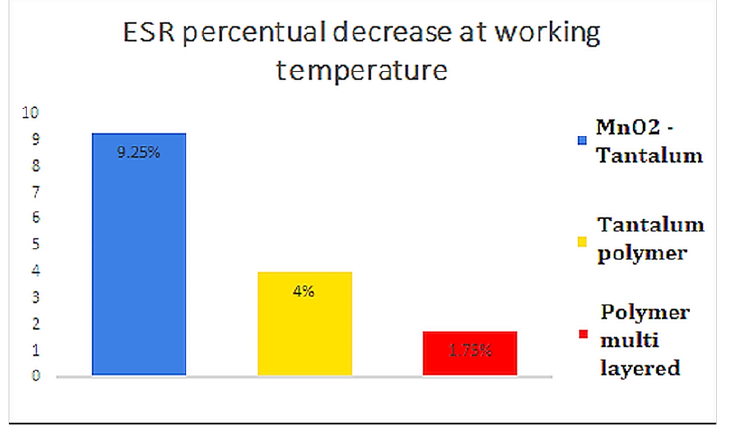
Figure 16. ESR percentage decrease at working temperature of the capacitor within mission profile, depending on capacitor’s technology.